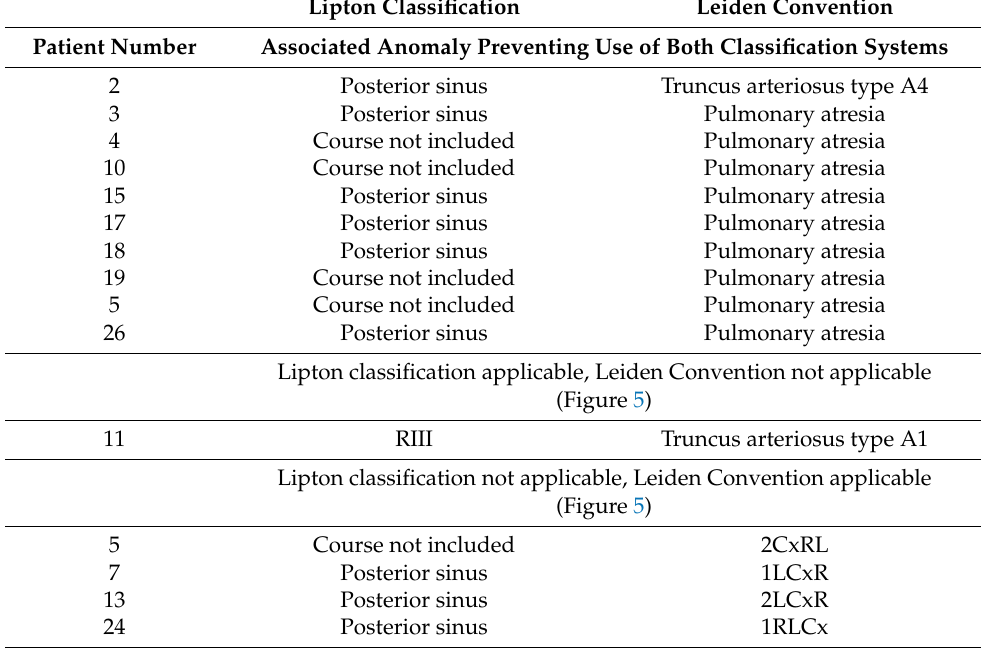
Table 2. Overview of cases not assessable by either